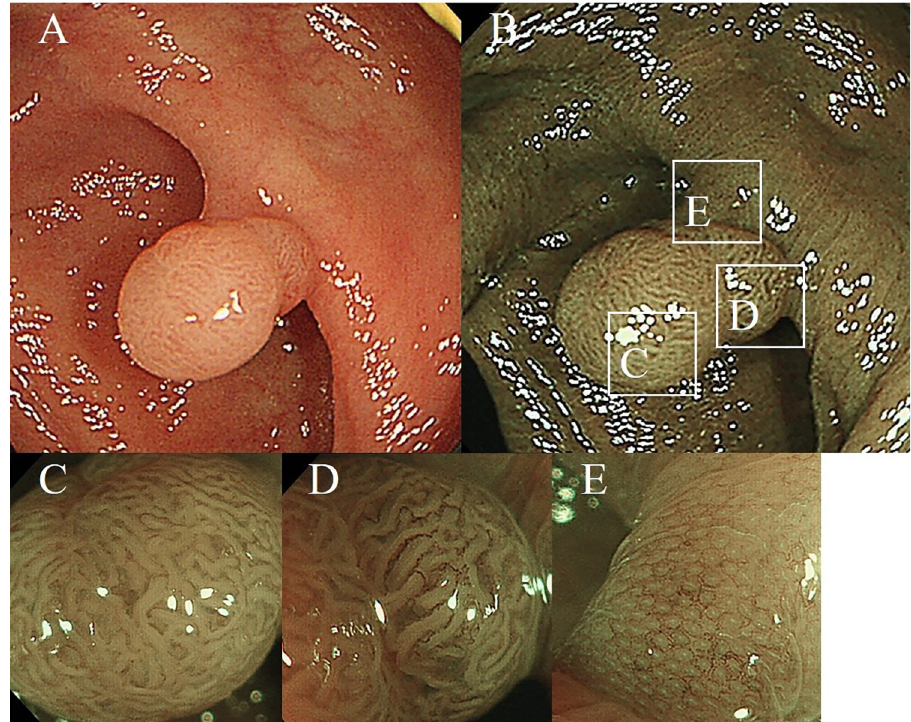
Fig 1. Qualitative and quantitative evaluation of colonic polyp with WLI (A), NBI (B) and NBI-M (C, D, and E).